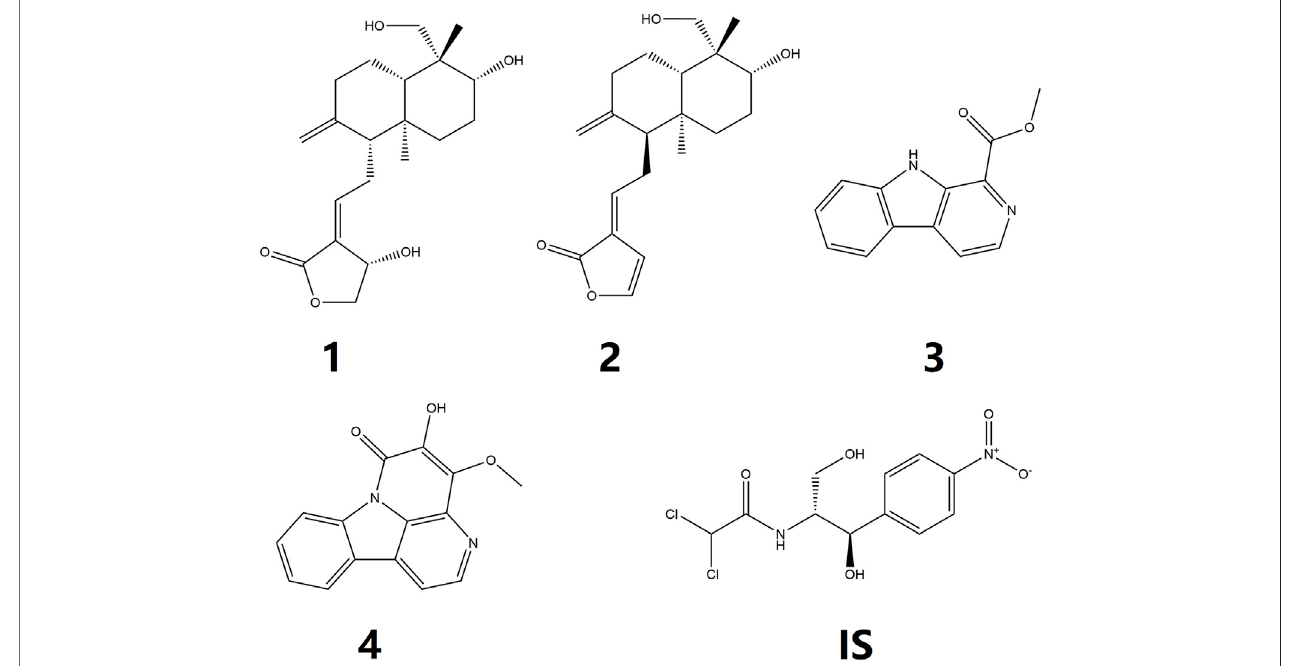
FIGURE 1 | Chemical structures of 1 andrographolide, 2 dehydroandrographolide, 3 1-methoxicabony- β -carboline, 4 4-methoxy-5-hydroxy-canthin-6-one, and chloramphenicol ( IS ).